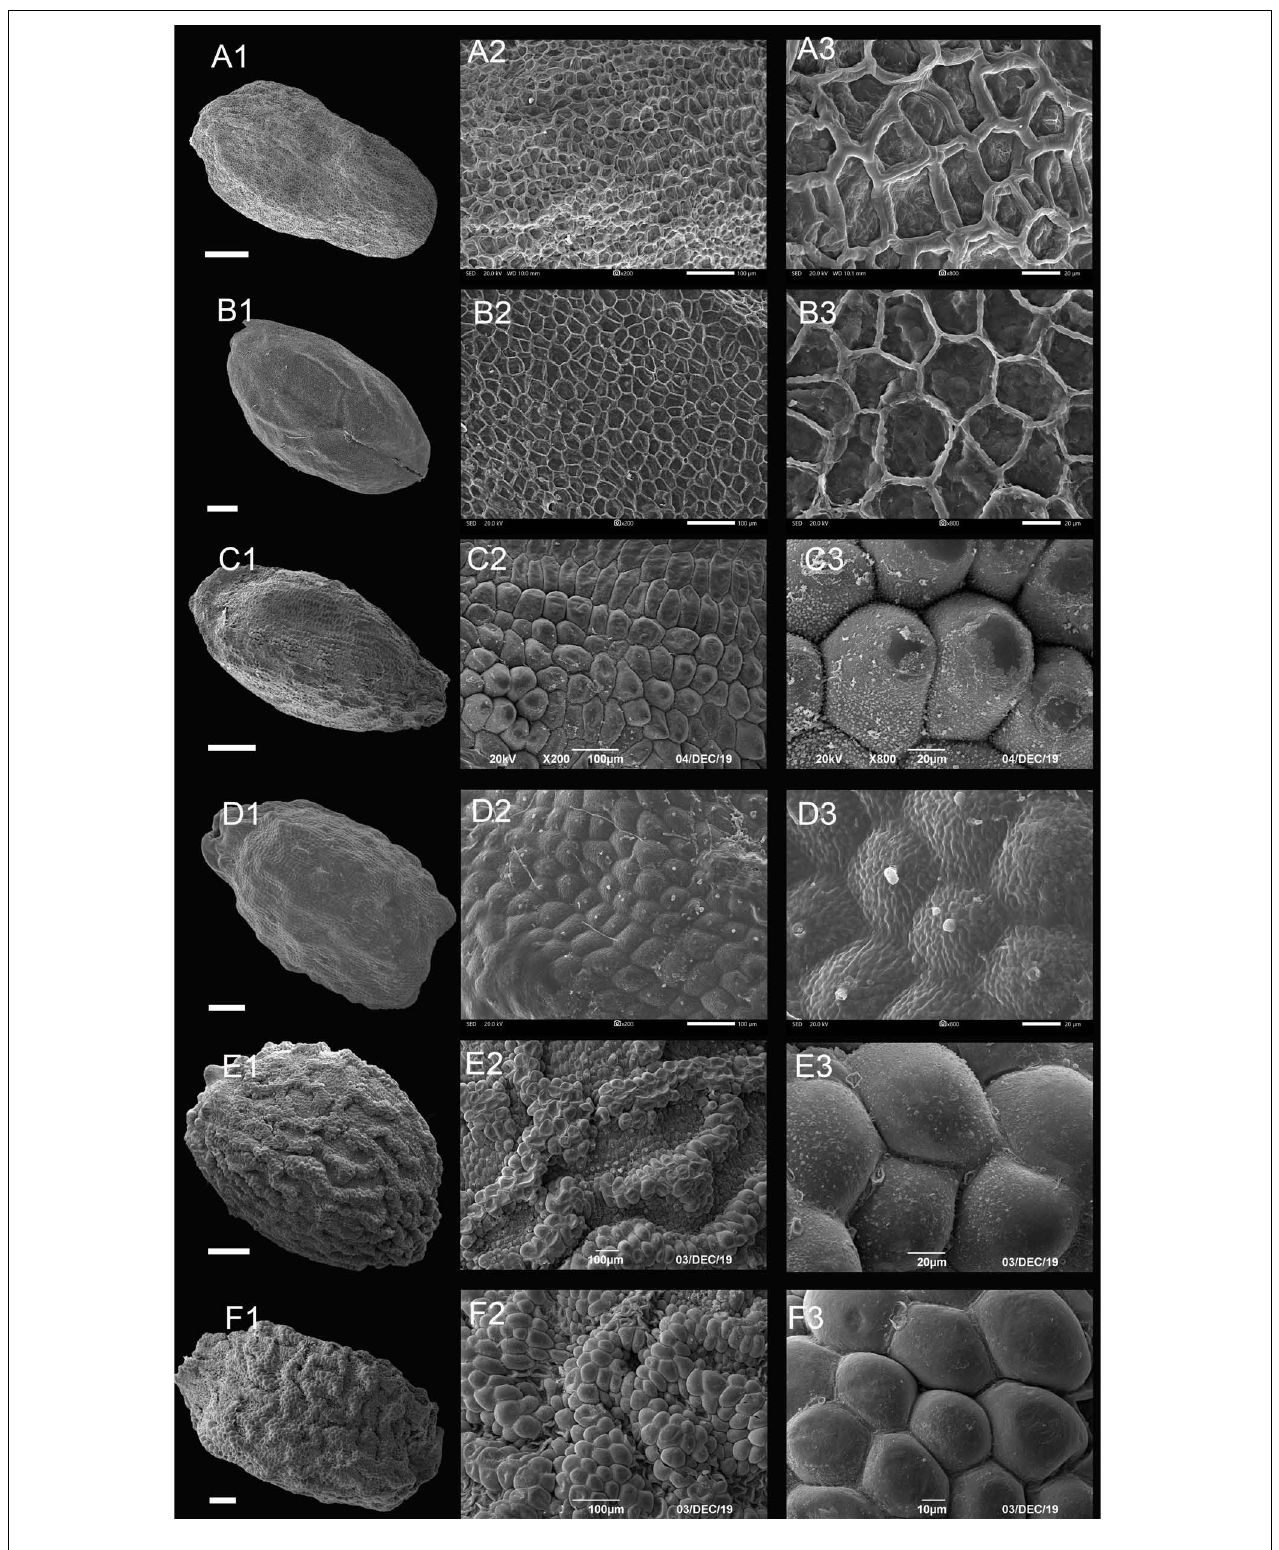
FIGURE 3 | Scanning electron microscope images of seeds from reticulate type of Impatiens . (A1–F1) Whole view; (A2–F2,C3–F3) Partial view. (A1–A3) Impatiens rapiformis , (B1–B3) Impatiens maculifera , (C1–C3) Impatiens cyanantha , (D1–D3) Impatiens sulcata , (E1–E3) Impatiens pterosepala , (F1–F3) Impatiens leptocaulon . Scale bars: (A1–E1) = 500 µ m, (F1) = 200 µ m.